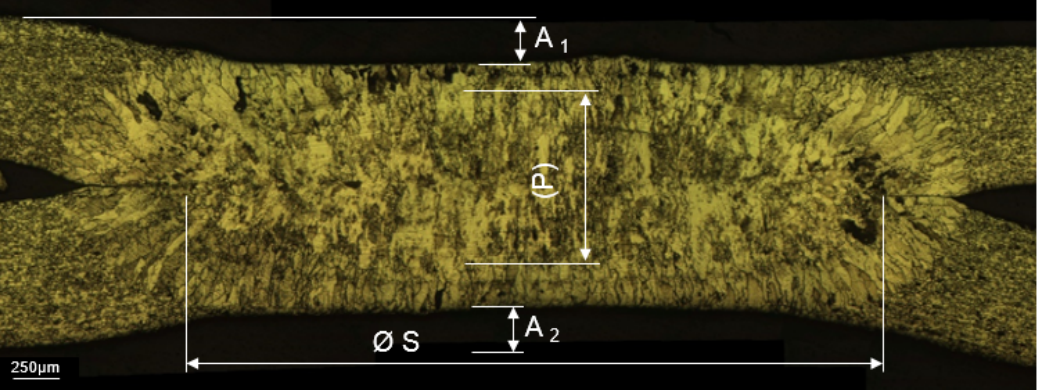
Figure 6. Example of macrography in relation to the resistance spot welding process (RSW).